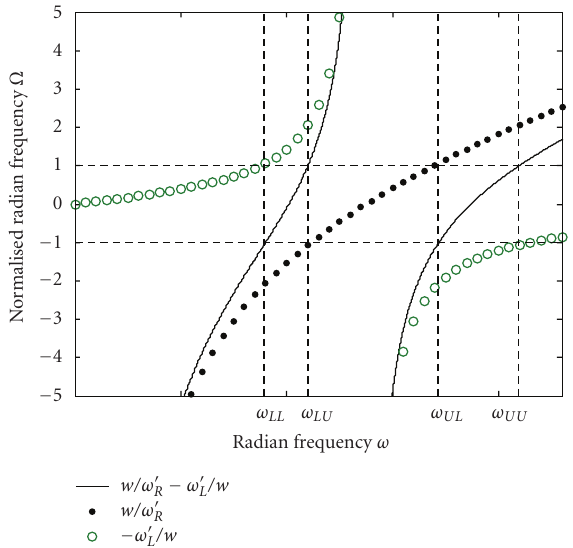
Figure 3: Mapping from normalized frequency of a prototype low- pass filter into actual filter frequency. (The solid line, plotted by Ω = − ω (cid:2) w/ω (cid:2) /w , is for the dual-band bandpass filter. The circle and dot R L lines describe the bandstop transformation with minus sign, Ω = − ω (cid:2) /w , and the bandpass transformation, Ω = w/ω (cid:2) L w = ω 0 ( ω/ω 0 − ω 0 /ω ) . )